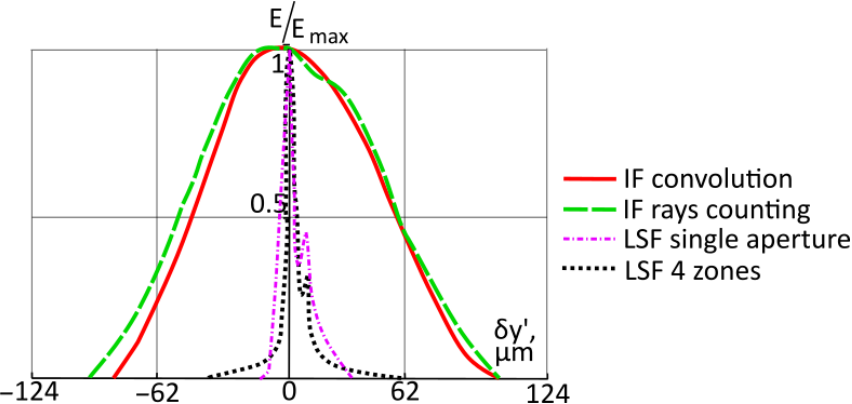
Figure 4. Instrument function computation